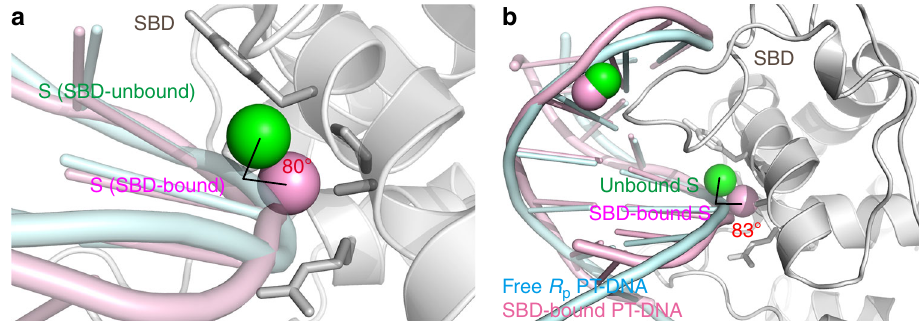
Fig. 4 The sulfur atom rotates ~80° outward upon association with ScoMcrA-SBD. a Comparison between the SBD-bound and SBD-unbound strands of the same PT-DNA molecule in the structure of ScoMcrA-SBD in complex with PT-DNA. An 80° outward rotation of the sulfur atom can be observed, which makes it more suitable for accommodation by the sulfur-binding cavity on ScoMcrA-SBD. b Comparison between the free and SBD-bound PT-DNA also shows that the sulfur atom rotates 83° outward upon its recognition by